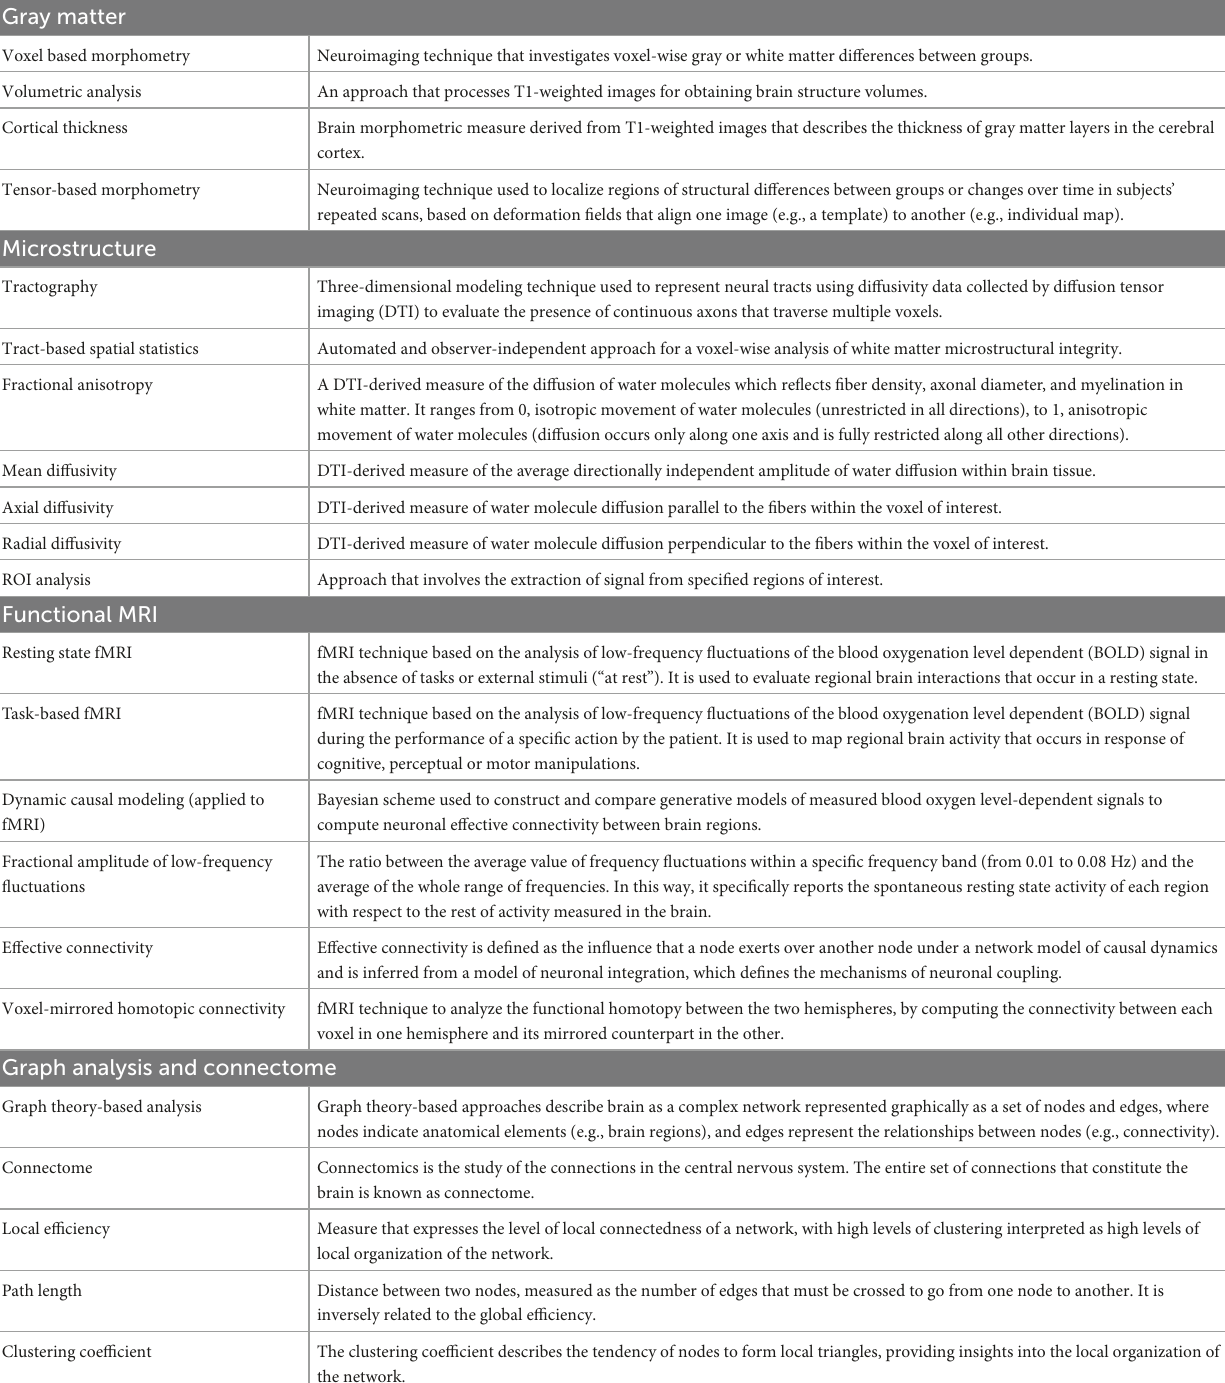
TABLE 2 Glossary of the technical terms used in this